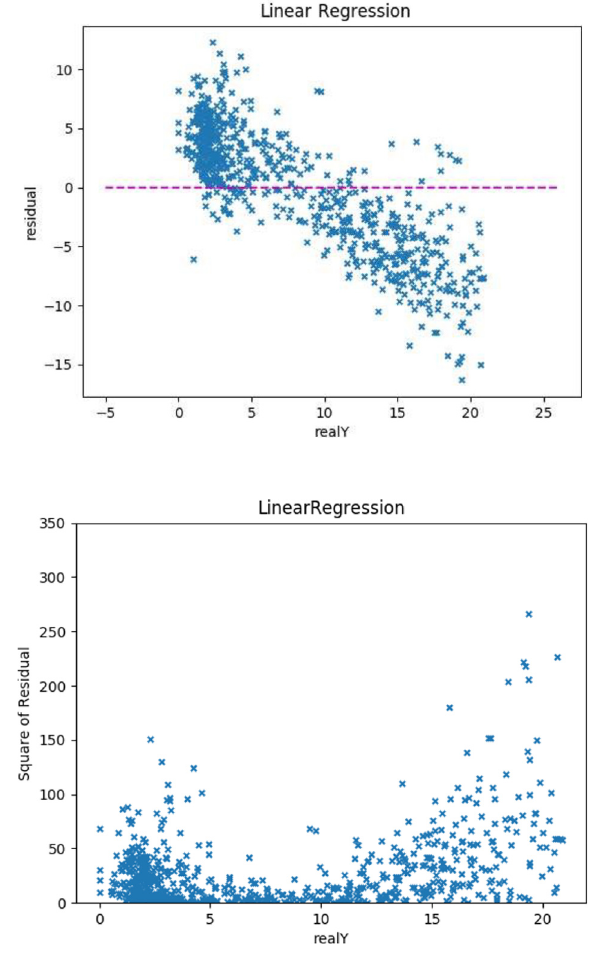
Figure 5. Square of residual (linear